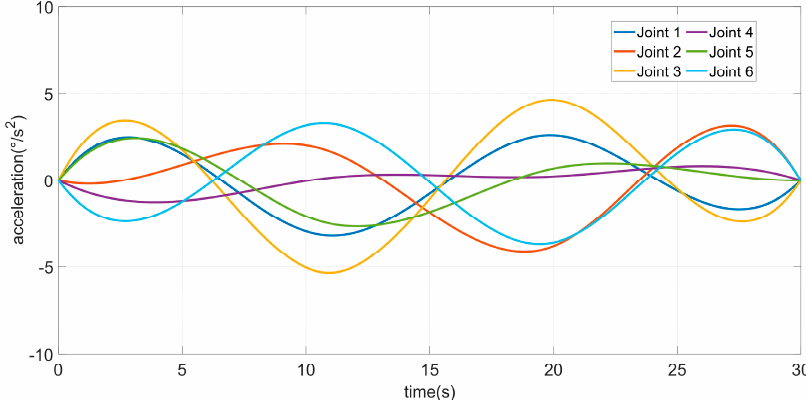
Figure 6. Acceleration curves of all joints by the proposed technique ( T f = 29.9930 s).